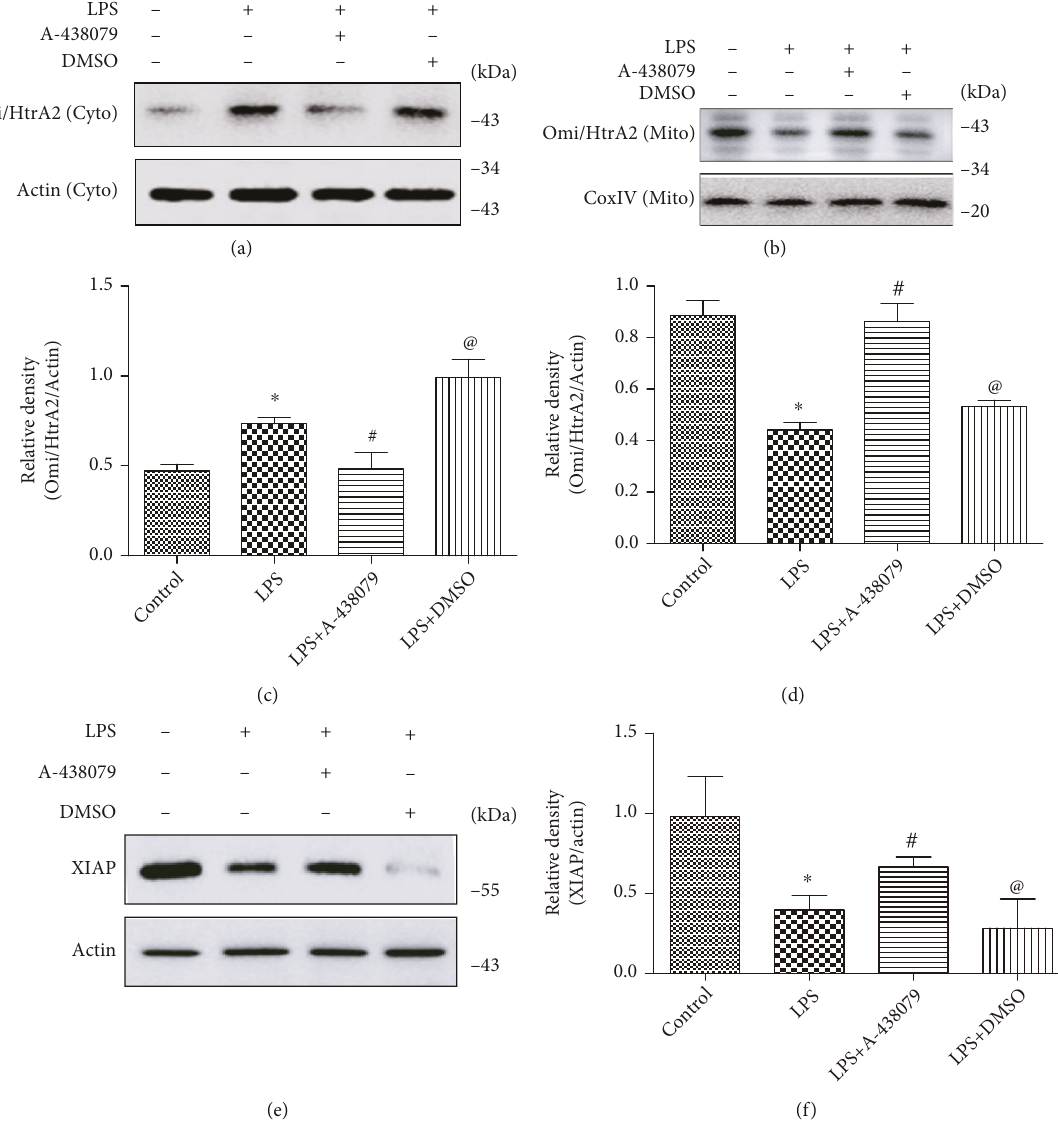
Figure 4: A-438079 treatment decreased LPS-induced transposition of Omi/HtrA2 from mitochondria to cytoplasm and reversed the decrease in XIAP expression. (a) and (c) A-438079 reduced LPS-induced increase of Omi/HtrA2 in the cytoplasm of HBMECs in vitro. All data are expressed as mean ± SD . ∗ P < 0 : 05 compared with control, # P < 0 : 05 compared with LPS, and @ P < 0 : 05 compared with LPS + A − 438079 . (b) and (d) Under the e ff ect of LPS, the mitochondrial Omi/HtrA2 of HBMECs in vitro was signi fi cantly decreased compared with the control group, and this reduction could be inhibited by A-438079. All data are expressed as mean ± SD . ∗ P < 0 : 05 compared with control, # P < 0 : 05 compared with LPS, and @ P < 0 : 05 compared with LPS + A − 438079 . (e) and (f) Western Blot showed that LPS treatment could inhibit the expression of the apoptosis inhibitor protein XIAP and could be reversed by A-438079. All data are expressed as mean ± SD . ∗ P < 0 : 05 compared with control, # P < 0 : 05 compared with LPS, and @ P < 0 : 05 compared with LPS + A −